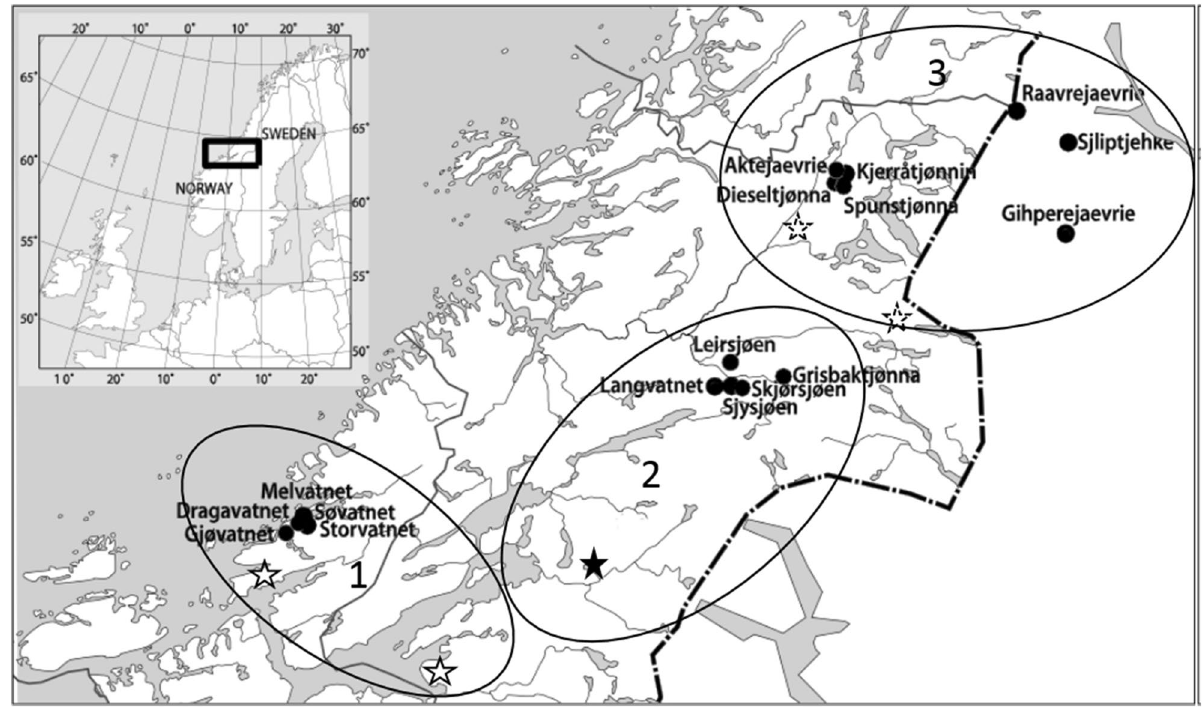
Figure 5. Study lake positions (filled dots) and names. Unfilled large circles connects the different lakes with the most representative weather stations (stars) in the area (in terms of altitude, vegetation zones and landscape). The dashed line constitute the national border between Norway and Sweden. The figure was produced using Adobe